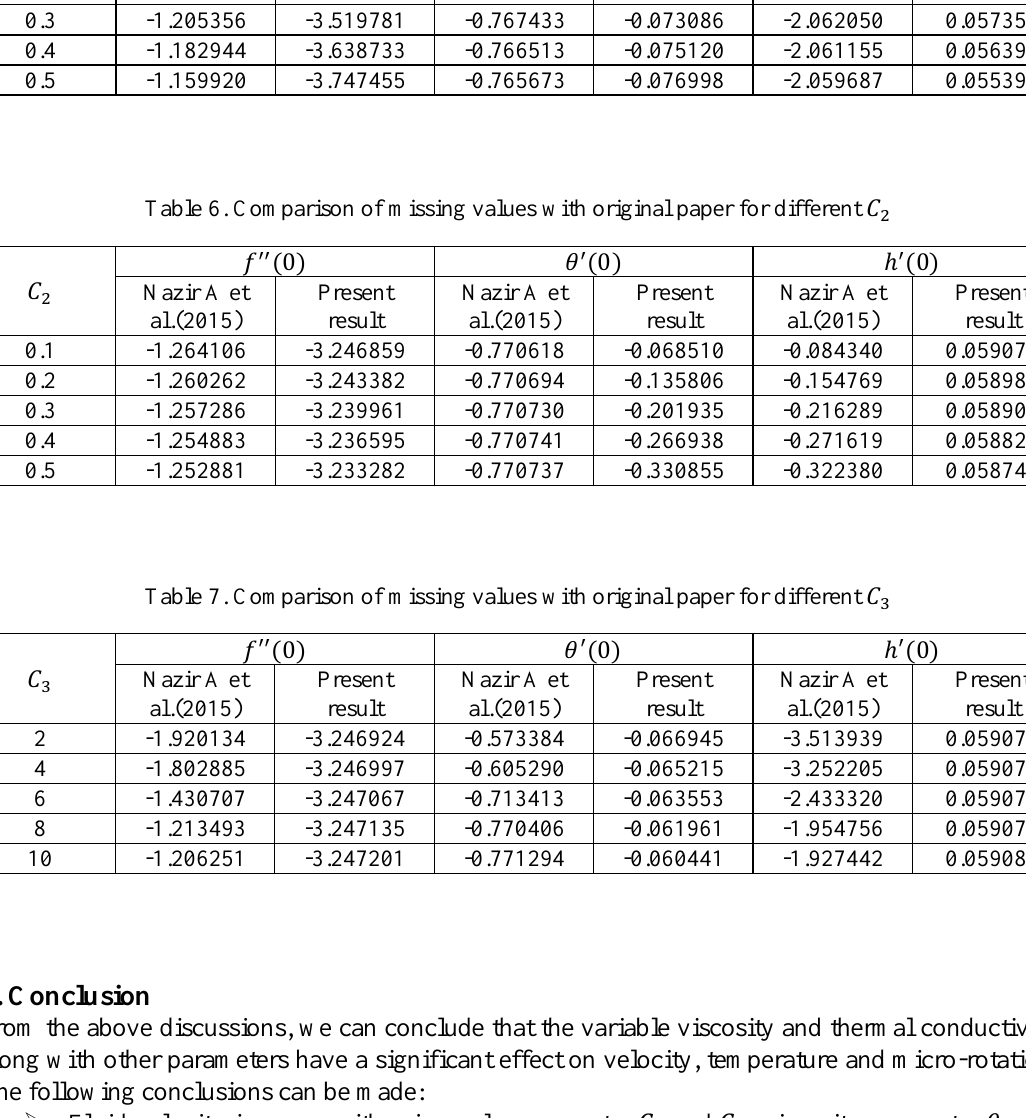
Table 5. Comparison of missing values with original paper for different 𝐶